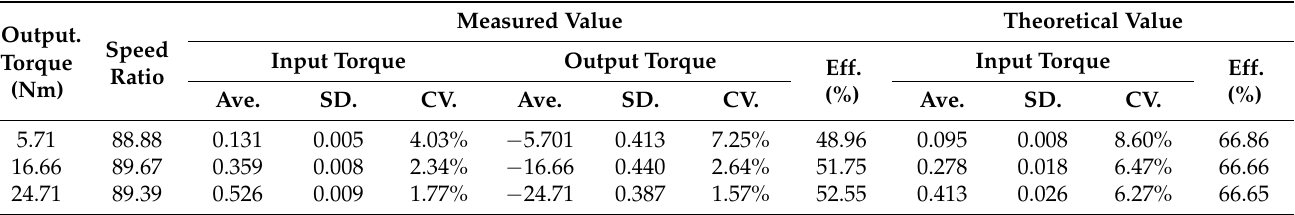
Figure 8. Experimental platform for LCR II: ( a ) prototype of LCR II; ( b ) the framework of the experimental platform; ( c ) the image of the experimental platform. Table 4. Experimental results of LCR II.